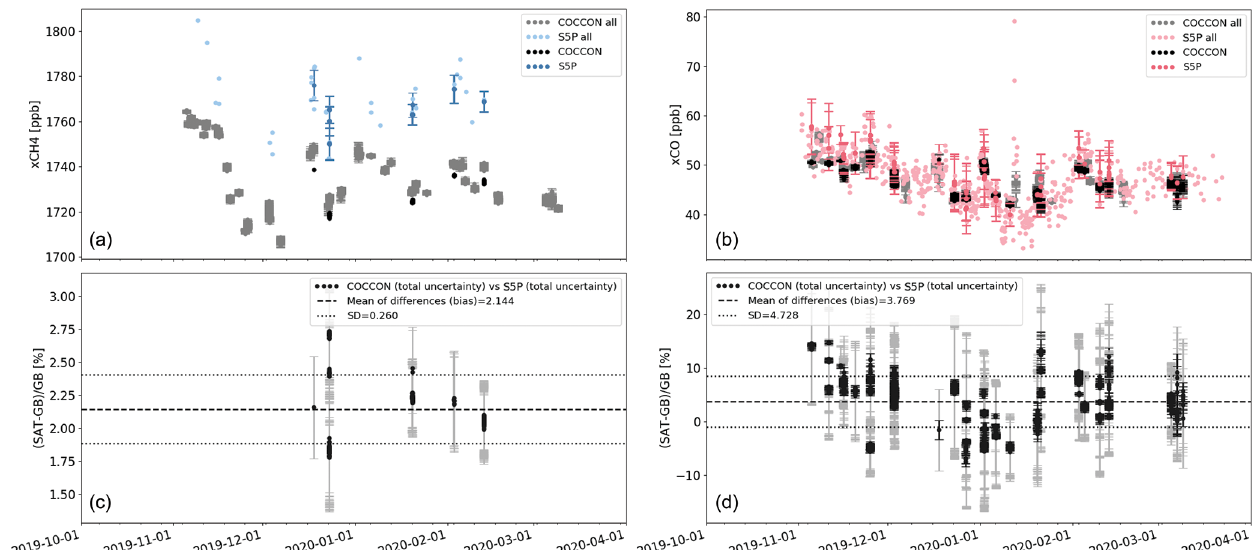
(a, c) and X CO (b, d) showing all retrievals and overpass means (a, 4